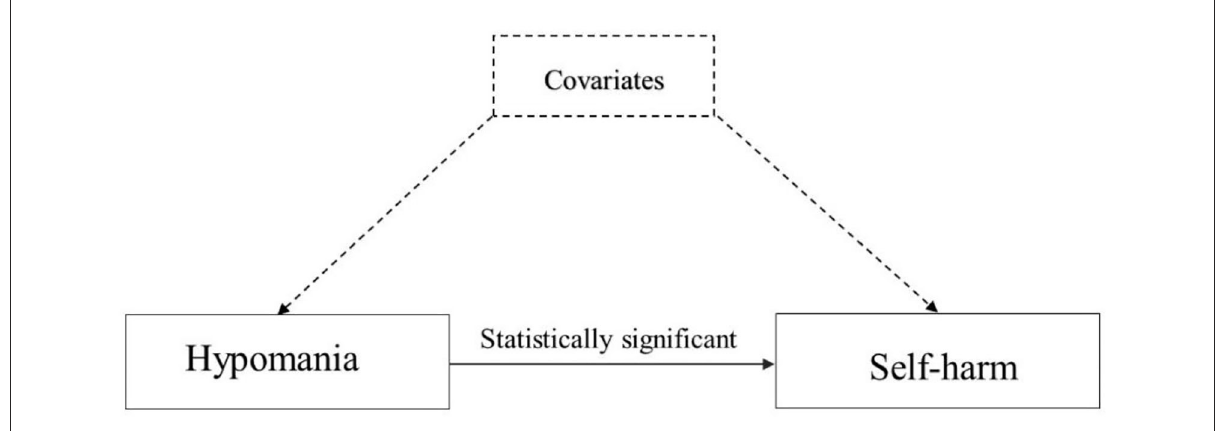
FIGURE1 The hypothesized association between hypomania and